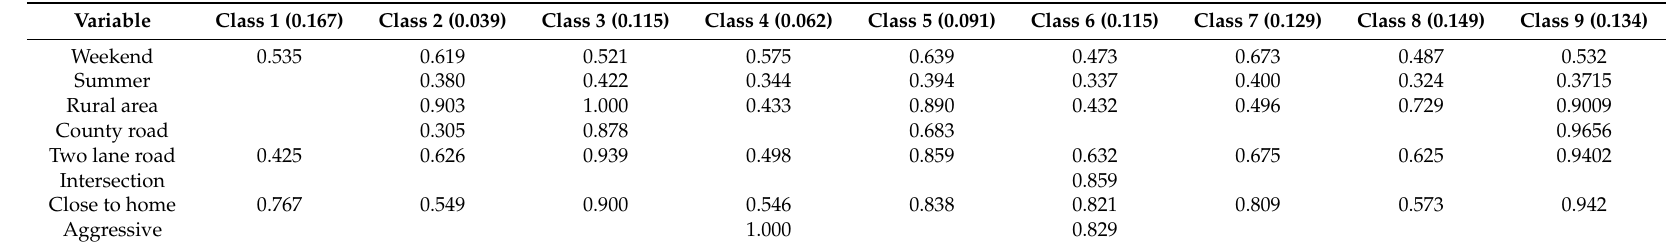
Table 4. Latent classes of young male fatal crash